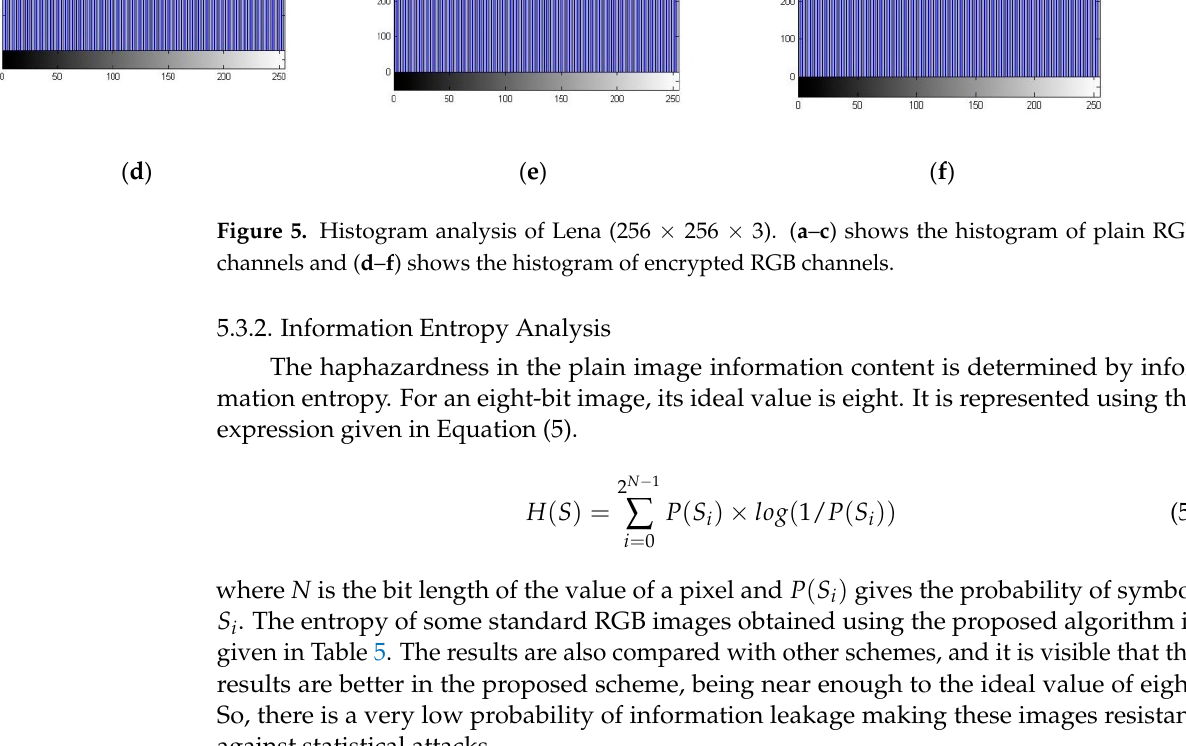
Table 5. Information entropy analysis.